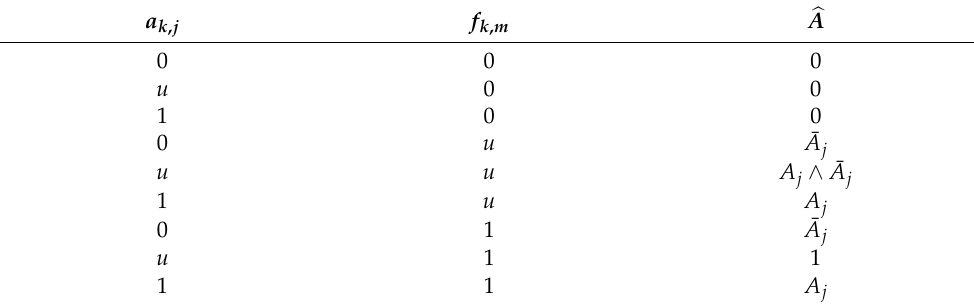
Table 4. Function values